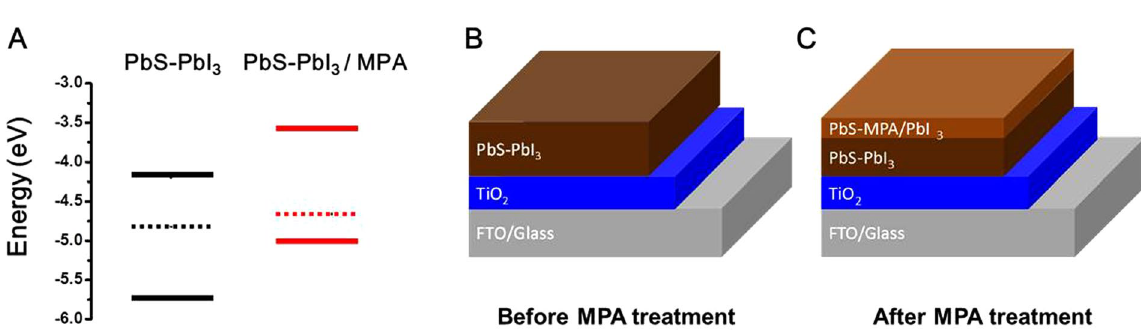
Figure 5. ( A ) Energy levels of conduction band minimum and valence band maximum and Fermi energy level versus vacuum level of PbS-PbI 3 solids before and after MPA treatment, as determined by UPS measurements (Fig. S16). Structures of film of PbS QDs before ( B ) and after ( C ) MPA